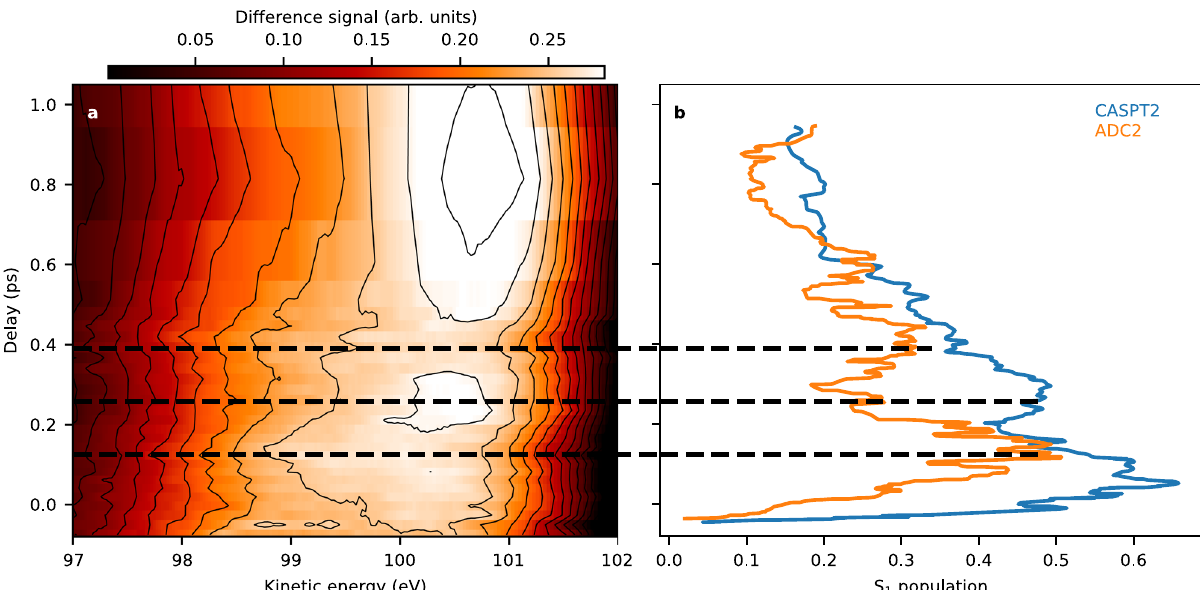
Fig. 3 Experimental shifts and theoretical predictions on state population. a False-colour contour plot of the positive lobe in Fig. 2b, normalised on the time-dependent area under the lobe. An oscillatory dynamic in the lineshape and position is visible for the fi rst ~600 fs. At 150 fs and 400 fs delay, the spectrum is shifted to lower kinetic energy, while it is shifted to higher kinetic energies in between and afterwards. b Comparison of the oscillation dynamics with trajectory simulations. The population of the S 1 ( n π * ) state, obtained from CASPT2 calculations of Ref. 35 (blue line) and ADC(2) calculations of Ref. 36 (orange line) are plotted. The dashed lines highlight the extrema of the oscillation observed in the experiment. The theoretical simulations do not include fi nite time-resolution and we shifted them by 50 fs to smaller delays to induce a transient rise of the signal around zero delay. The experimental 250 fs oscillation features have their counterparts in the simulated S 1 population, indicating the observation of a population exchange between the S 1 state and other electronic states. Source Data (for a) are provided as Source Data fi